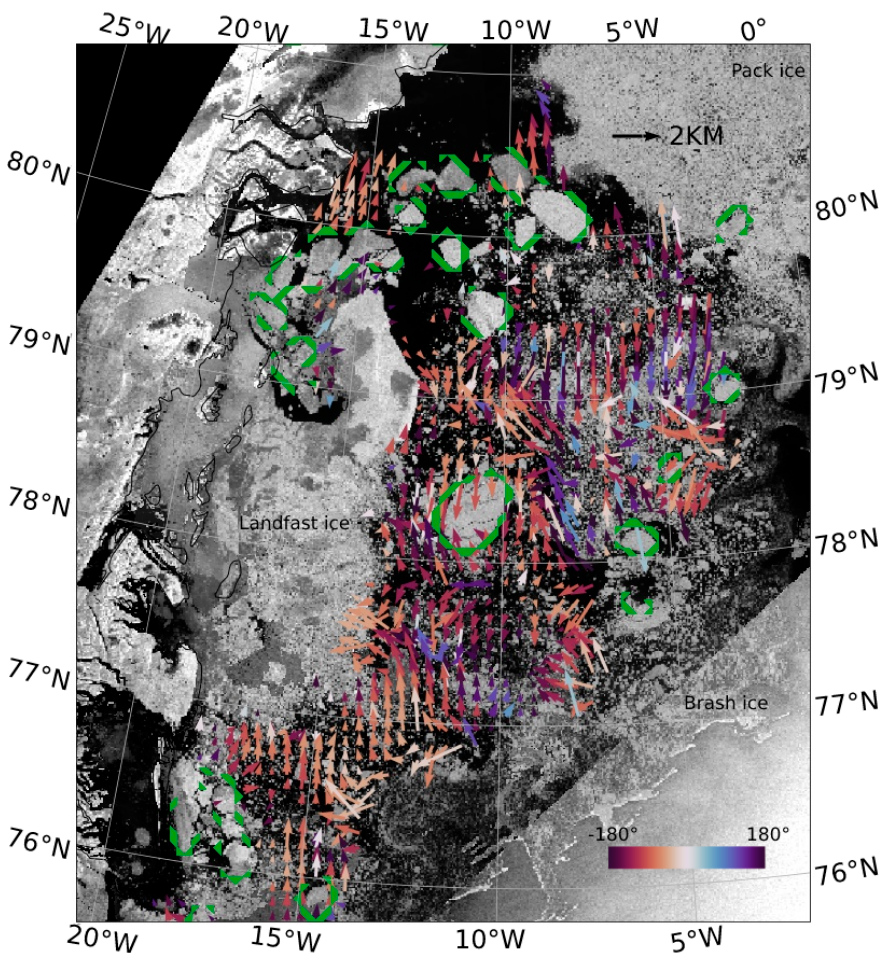
Figure 9. Output ice drift vectors plotted on the 30 July S-1 image. Colors indicate rotation of floes, ranging from − 180° to 180° (positive numbers represent clockwise and negative numbers counterclockwise rotation, respectively). The length of the vectors shows the displacement of the sea ice. Large floes are highlighted in green.